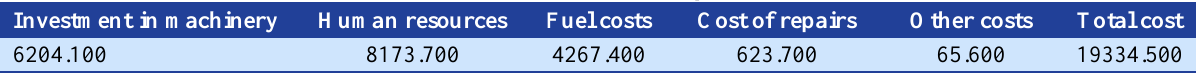
Table 3. Financial costs of solid waste collection and transportation in 2015 (in 106 IRR)